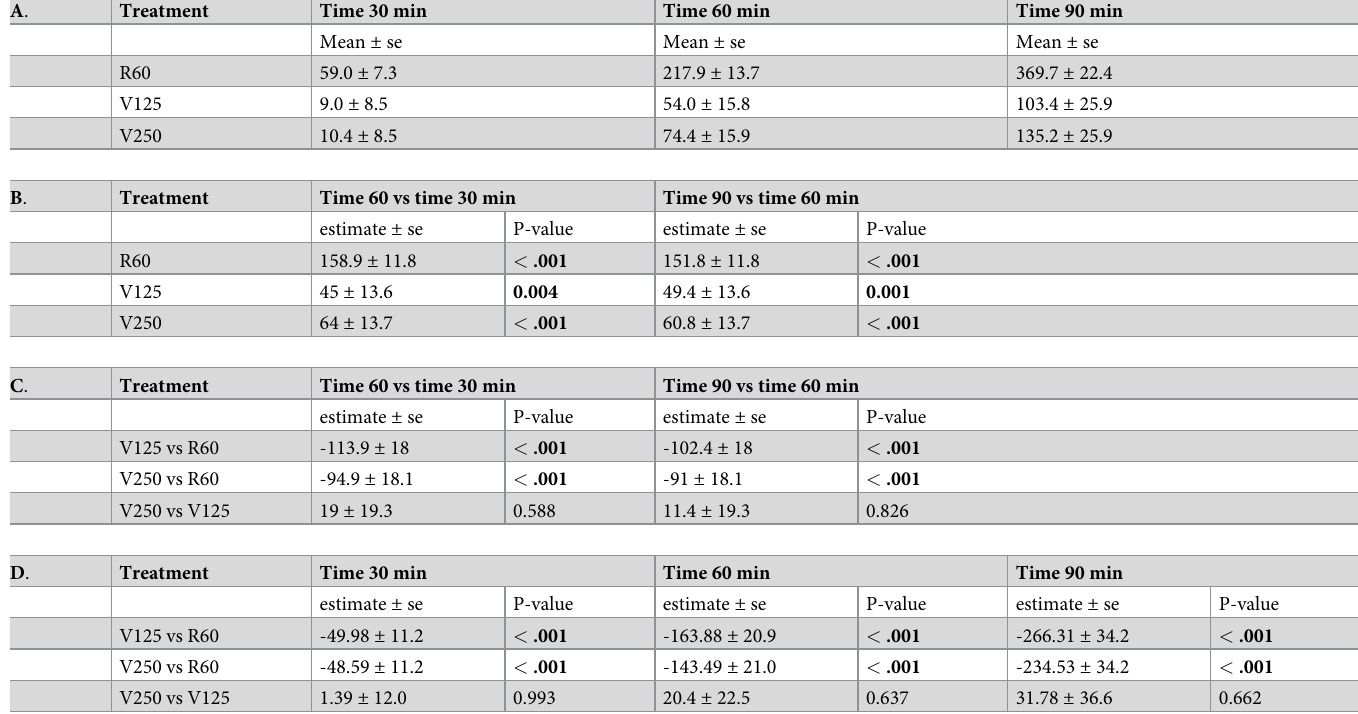
Table 2. The outcomes of linear mixed effect model used to investigate the effect of incubation time and treatment on the rhodamine concentration ( μ M) of the droplets secreted. A . Treatment